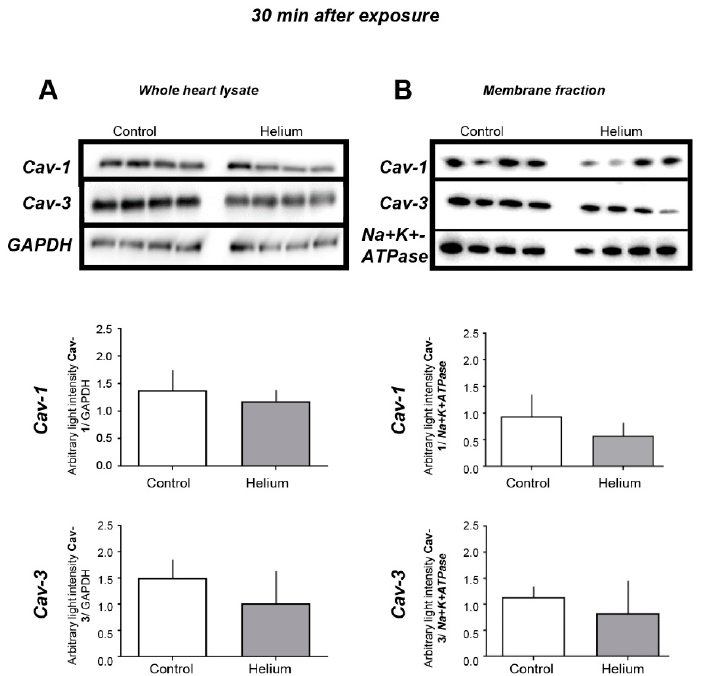
Figure 2. Cav-1 and Cav-3 levels in cardiac tissue 30 min post helium exposure. ( A ) Cav-1 and Cav-3 levels measured by western blot analysis in whole-heart tissue of mice as was the internal standard GAPDH, n = 8. ( B ) Cav-1 and Cav-3 levels measured by western blot analysis in membrane fractions of mice, as was the internal standard Na + K + -ATPase, n = 4. Data are shown as mean ± SD. No significant differences were observed in the different tissues 30 min post He exposure, suggesting that He does not have an effect on Cav ‐ 1 and Cav ‐ 3 levels in heart tissue 30 min post exposure.